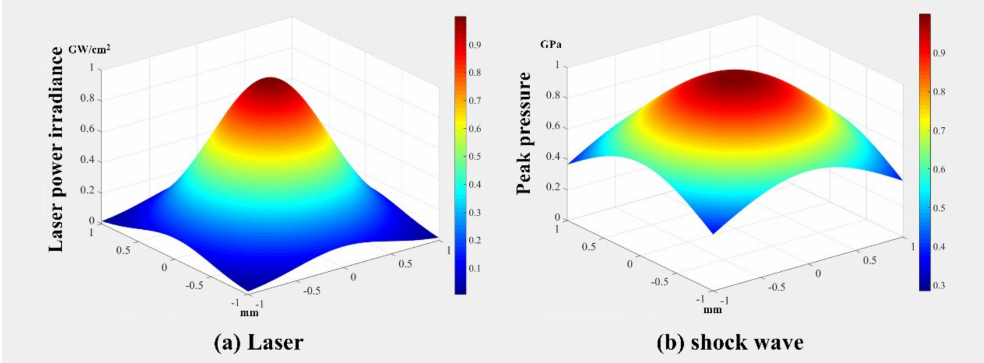
Figure 4. Spatial distributions of laser power irradiance and peak pressure of shock wave